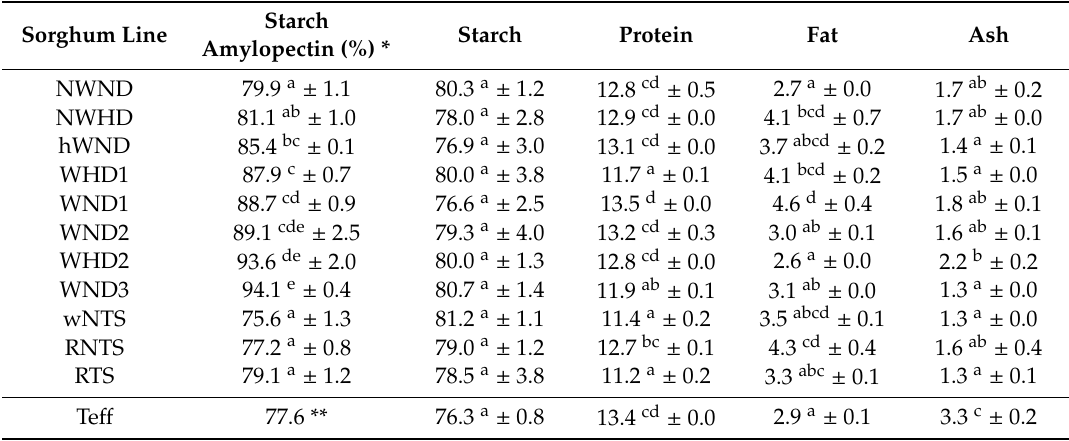
Table 2. Chemical composition of flours (g / 100 g, dry basis) of novel sorghum lines with waxy and high protein digestibility (HD) traits, normal sorghum types, and te ff . Sorghum